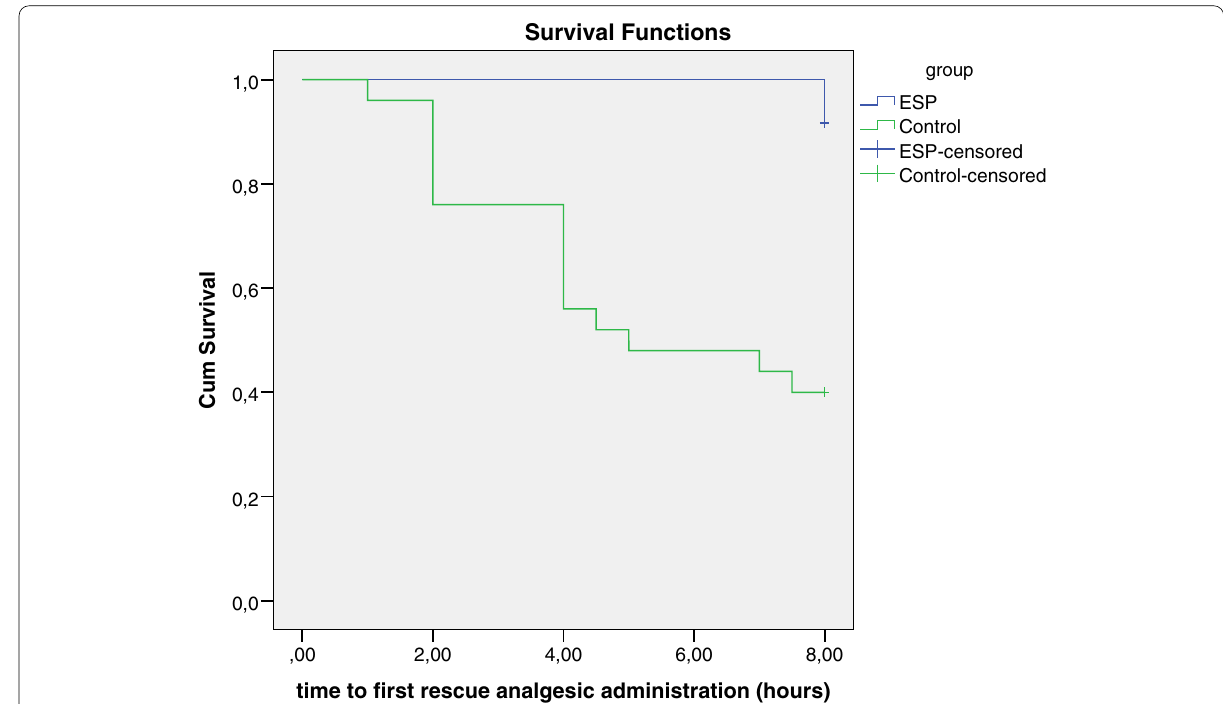
Fig. 4 Kaplan–Meier curve for the time to first rescue analgesic